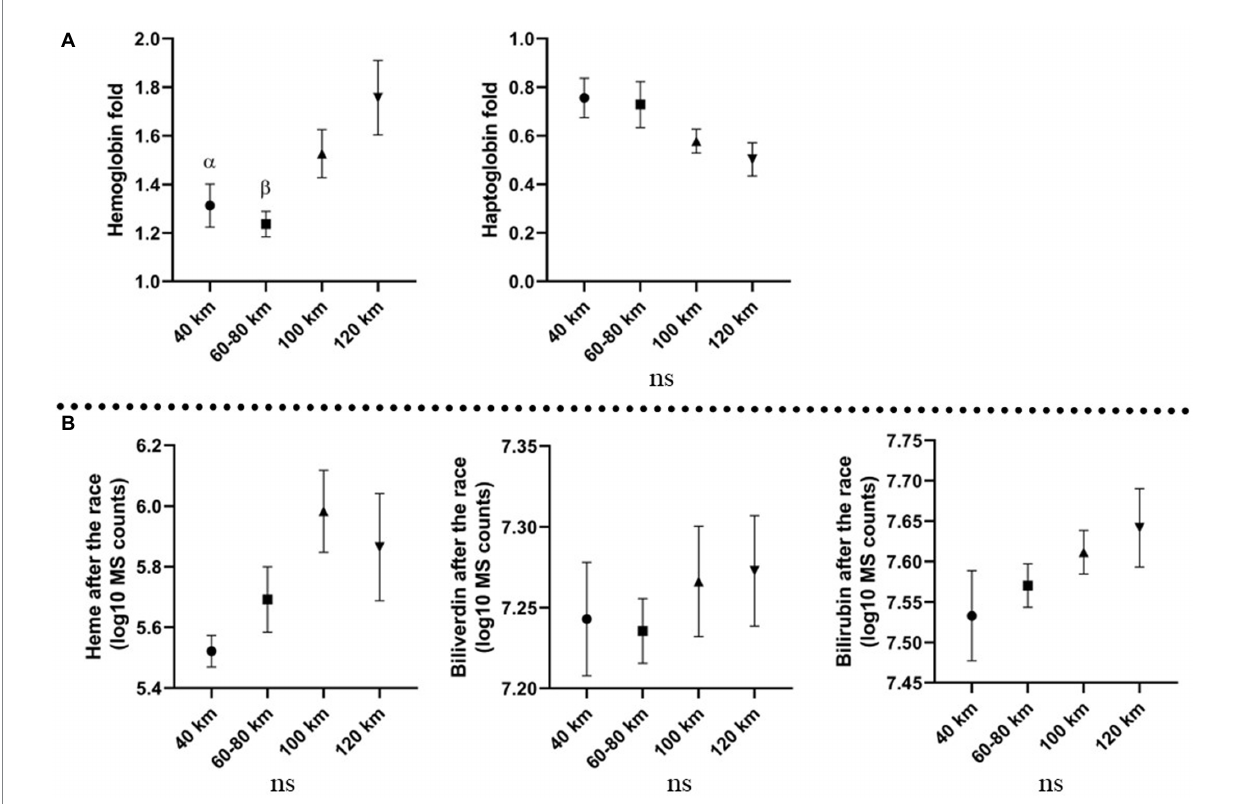
FIGURE 4 Association between distance ran and investigated molecules; (A) fold changes of the molecules analyzed with ELISA on different distance; (B) levels of molecules analyzed with metabolomics platform after the race on different distances, expressed in log10 MS counts; α : p ≤ 0.05, β : p ≤ 0.001 vs. 120 km; Mean values and standard errors of the mean are displayed.